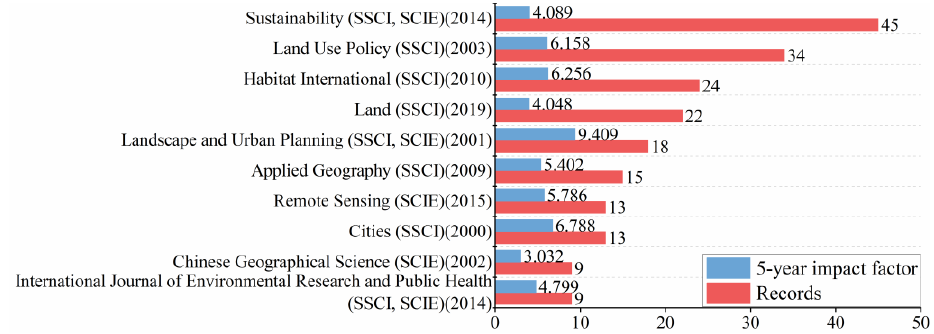
Figure 3. Top ten influential journals for publications in DAUE. The number in brackets indicates the year that a DAUE paper was first published in this journal.